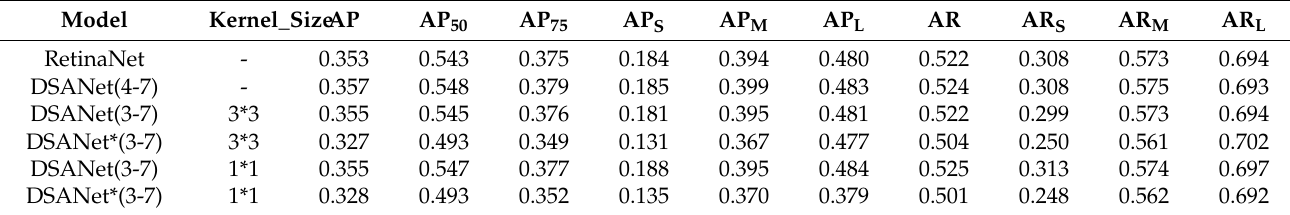
Table 5. Comparison of DSA with different convolution used in conv3, in which “3-7” or “4-7” refers to the DSA module added in FPN or ResNet conv3-7 or conv4-7 feature maps. DSANet* represents the use of ResNet instead of FPN as a backbone network. Convolutions with 3*3 kernel size need